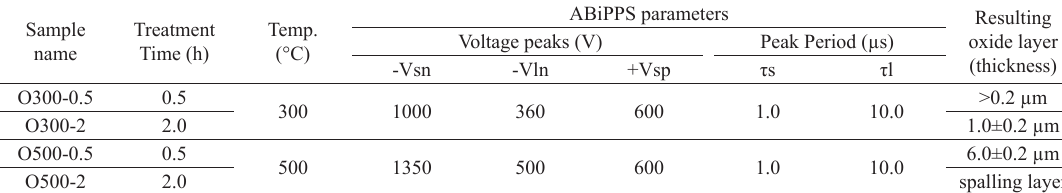
Table 1. Oxidation parameters and the resulting oxide layers thickness. Legend: -Vsn /-Vln / +Vsp (short-negative / long-negative / short-positive voltage peaks); τs / τl (short time / long